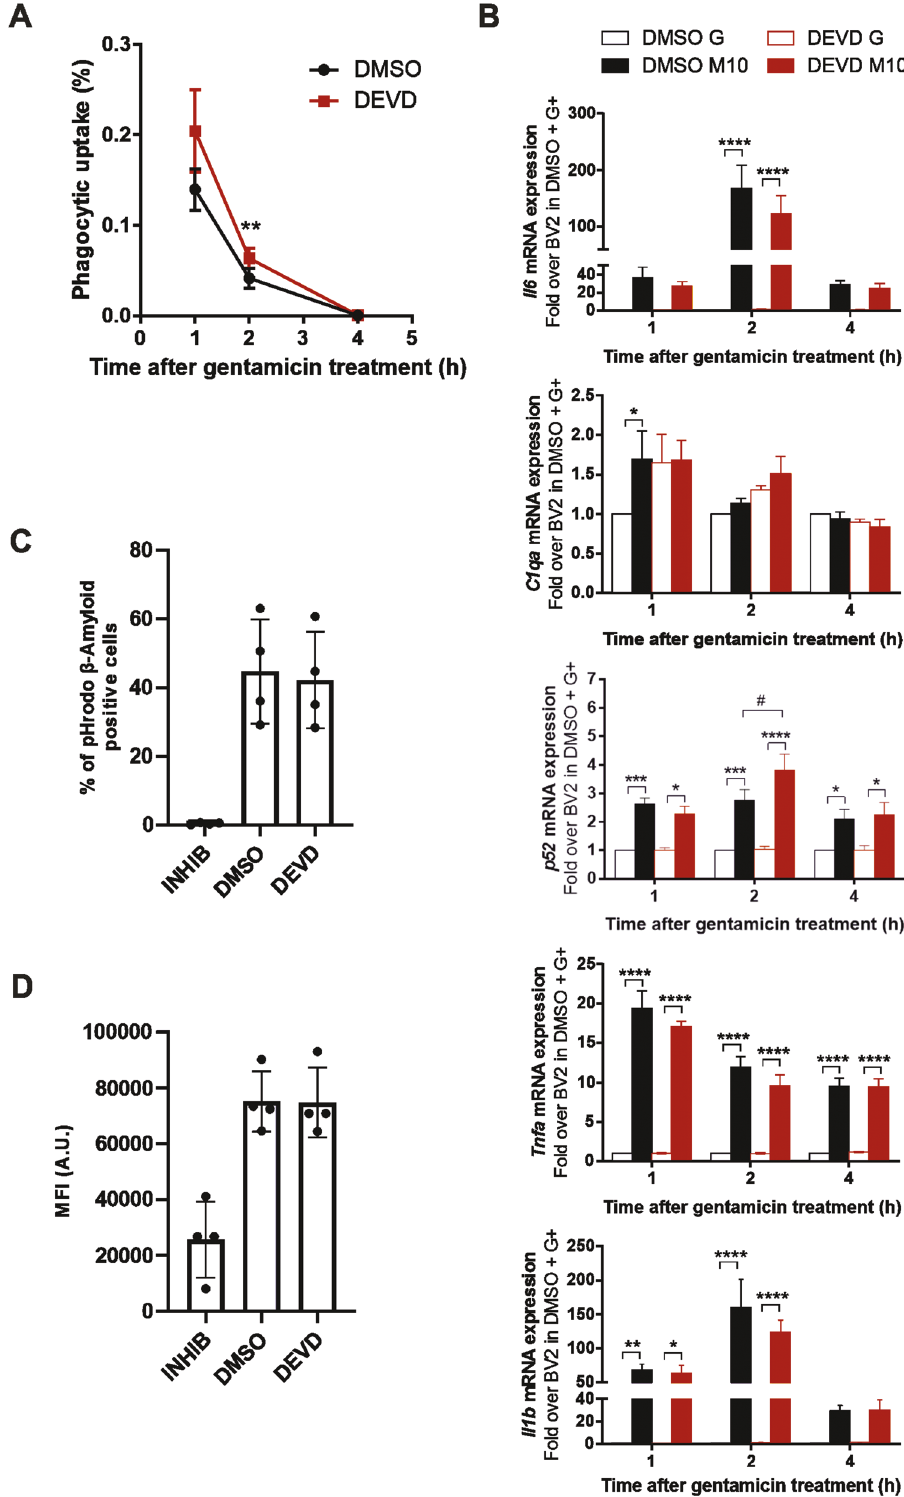
Fig. 5 Inhibition of COLEC12 cleavage by CASP3 increases microglial phagocytic ability for bacteria but not A β . A Phagocytic uptake of BV2 cells treated with DEVD-fmk or DMSO used as control at different time points after gentamicin addition. B qPCR analysis of Il1b , Il6 , Tnfa , Nfkb2-p52 and C1qa mRNA expression in BV2 cells treated with DEVD-fmk or DMSO used as control following bacterial incubation and gentamicin treatment (M10) or gentamicin alone (G). C , D A β phagocytosis capacity of BV2 cells after treatment with DEVD-fmk or DMSO or with inhibition of phagocytosis (INHIB) used as controls represented by the percentage of microglia cells positive for pHrodo stained A β ( C ) or Mean fl uorescence intensity (MFI) ( D ). Statistics were performed with a 2-way ANOVA from 4 ( C , D ) to 5 ( A , B ) independent experiments ±SEM compared to DMSO control; single data points are represented as dots. P value: *or #<0.05; **<0.01; ***<0.001; ****<0.0001.